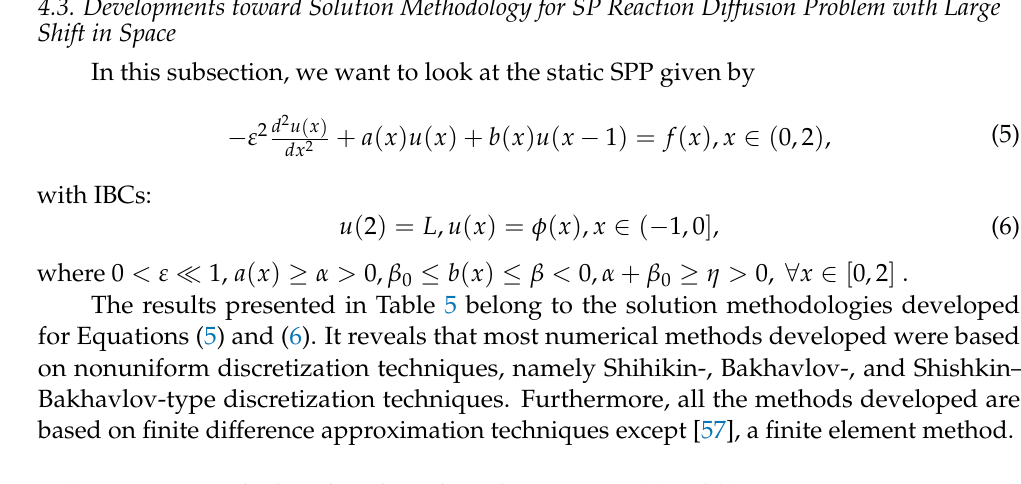
Table 5. Various methods and mesh used to solve Equations (5) and